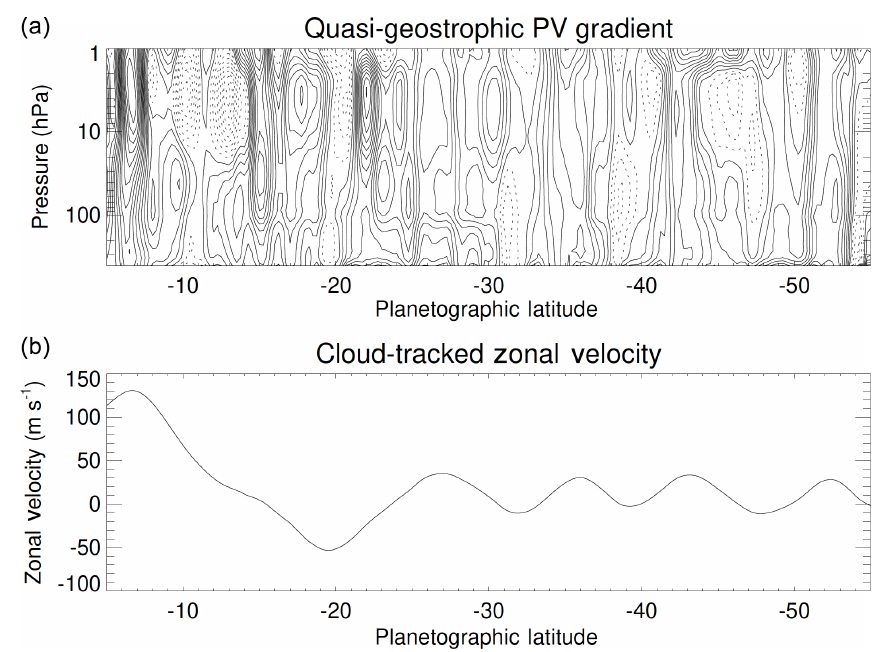
Figure 15. (a) Zonal-mean section of ∂Q/∂y (s − 1 m − 1 ) and (b) zonal-mean zonal wind (ms − 1 ) in the southern hemisphere of Jupiter, derived from Cassini observations by Read et al. (2006).